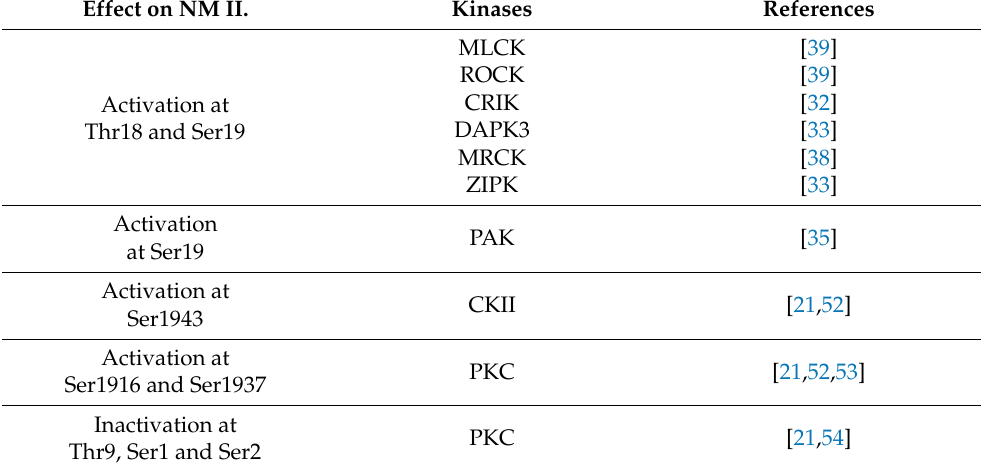
Table 1. Regulation of NM II. Several kinases regulate the activation/inactivation state of NM II through the phosphorylation of different Ser and Thr residues. Myosin light chain kinase (MLCK), Rho-associated protein kinase (ROCK), citron Rho-interacting kinase (CRIK), death-associated protein kinase (DAPK3), myotonic dystrophy-related Cdc42-binding protein kinase (MRCK), leucine-zipper- interacting kinase (ZIPK), p-21 activated kinase (PAK), casein kinase II (CKII), protein kinase C (PKC). Effect on NM